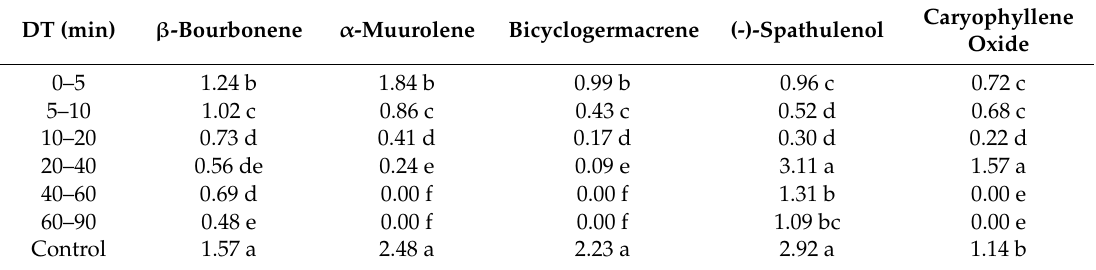
Table 10. Mean concentrations (%) of Hyssopus officinalis subsp. aristatus EO ( β -bourbonene, α -muurolene, bicyclogermacrene, (-)-spathulenol, and caryophyllene oxide) obtained from the seven distillation times (DT). Control = nonstop 0–90